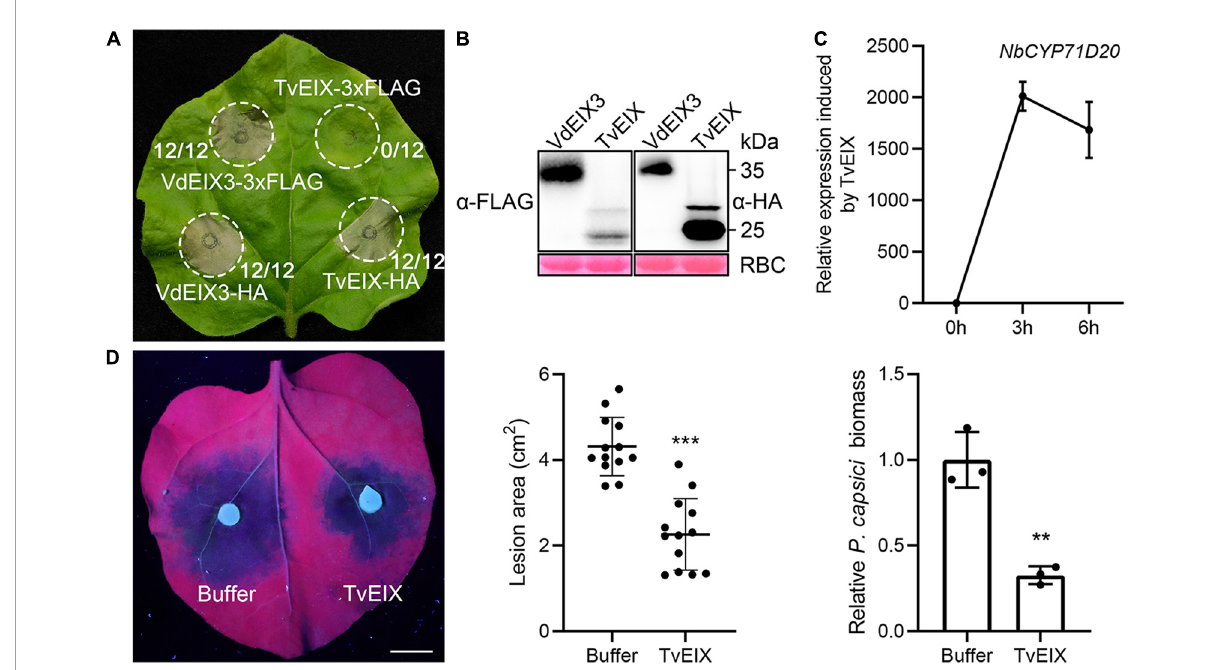
FIGURE1 Trichoderma viride ethylene-inducing xylanase (TvEIX) induces cell death and immune responses in Nicotiana benthamiana . (A) The carboxyl-terminal epitope fusions influence the cell death-inducing activity of TvEIX in N. benthamiana . The fraction numbers indicate the number of infiltrated leaves that have cell death phenotype/total number of infiltrated leaves. (B) Proteins that were transiently expressed in N. benthamiana leaves were detected by immunoblot using anti-HA antibody. Ponceau S staining of Rubisco (RBC) indicates the loading control. (C) TvEIX protein activates the expression of PTI marker gene NbCYP71D20 . (D) Pre-treatment of N. benthamiana leaves by 500 nM TvEIX protein significantly enhances plant resistance to the oomycete pathogen Phytophthora capsici . Photos were taken 36 h post inoculation under UV light. Data are shown as mean ± SD (Student’s t -test, *** P < 0.001). Bar, 1 cm. Relative P. capsici biomass in infected leaves was determined by qPCR (Student’s t -test, ** P <